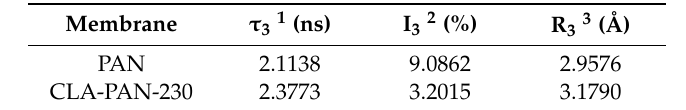
Table 2. o-Ps lifetime, relative intensity, and average free-volume radius data for PAN and CLA-PAN-230 membrane.